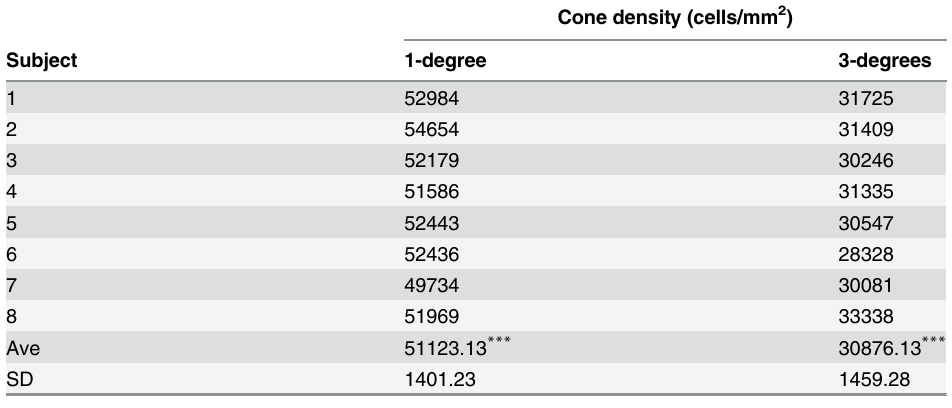
Table 1. Cone density at 1- degree and 3-degree retinal